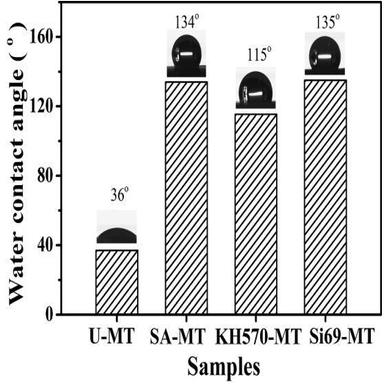
Water contact angles of untreated and modified MT particles.